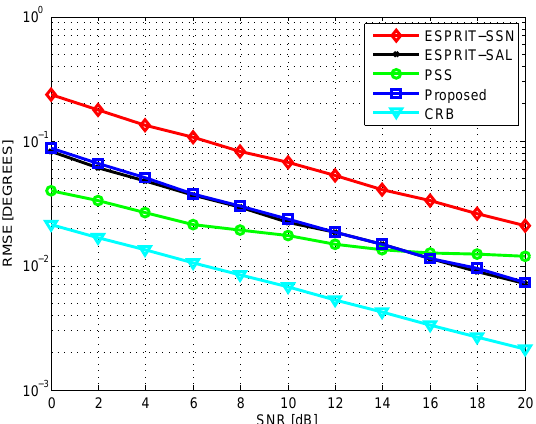
Figure 3. Root mean square error (RMSE) vs. signal-to-noise ratio (SNR), T = 200. CRB: Cramer–Rao bound; ESPRIT: estimation of signal parameters via rotational invariance technique; ESPRIT-SAL: ESPRIT with the same aperture length; ESPRIT-SSN: ESPRIT with the same sensor number.